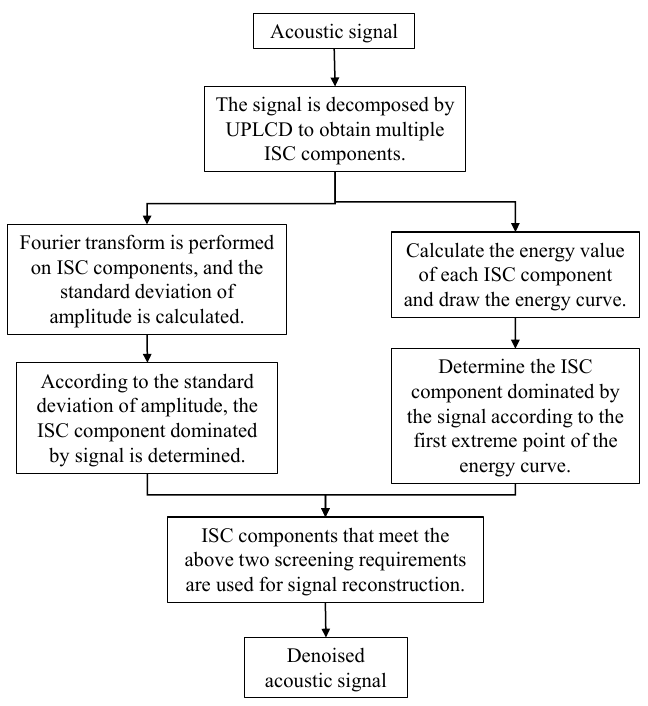
Figure 1. Denoising process of the signal.